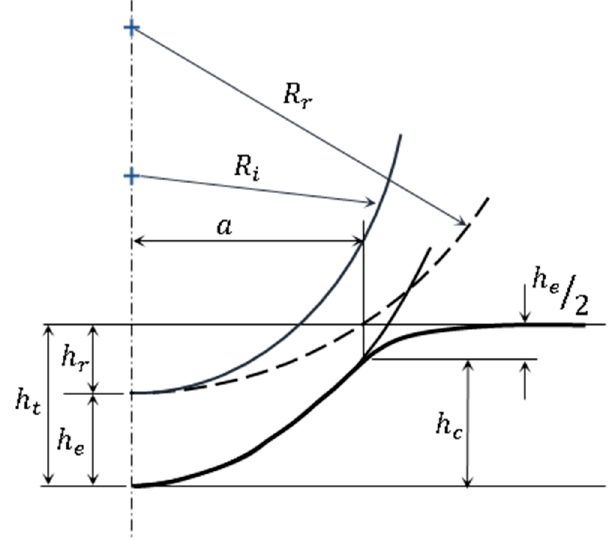
Figure A1. Schematic for spherical indentation. With multiple loading cycles during spherical indentation, the total penetration